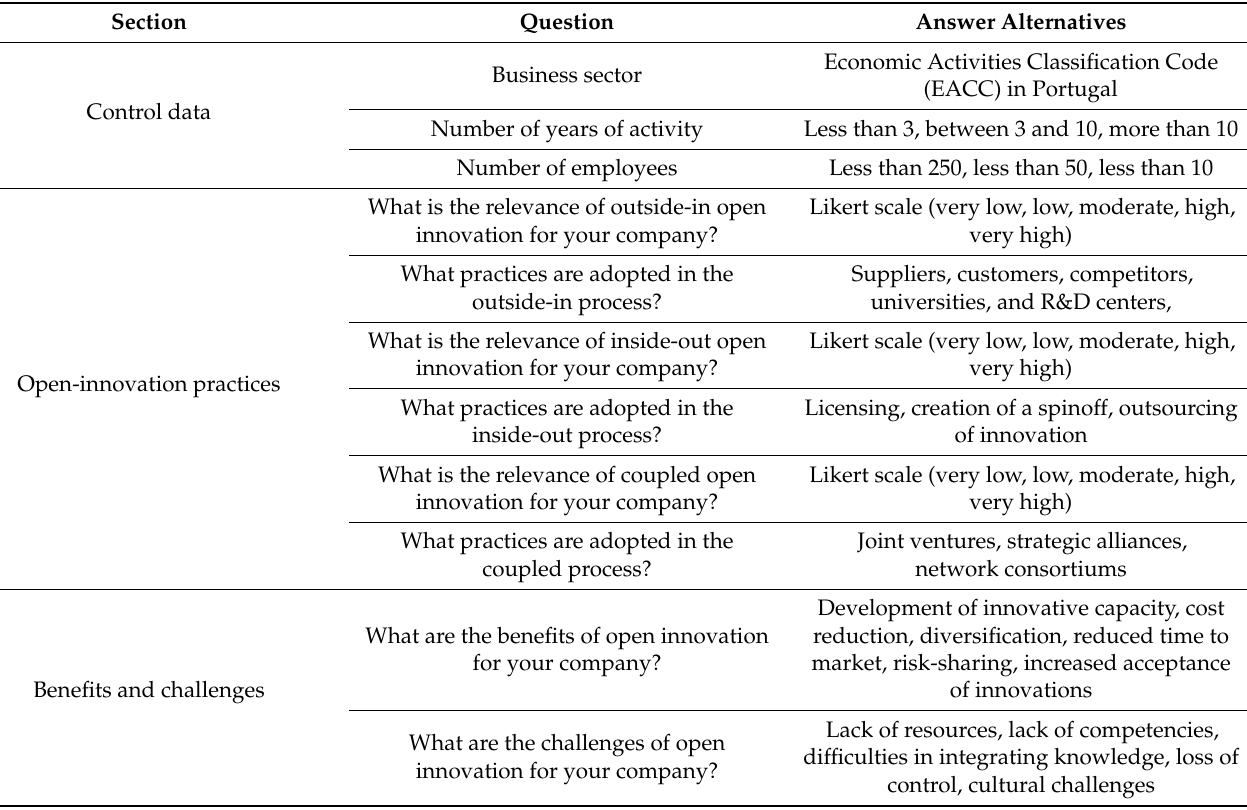
Table 1. Overview of survey structure.